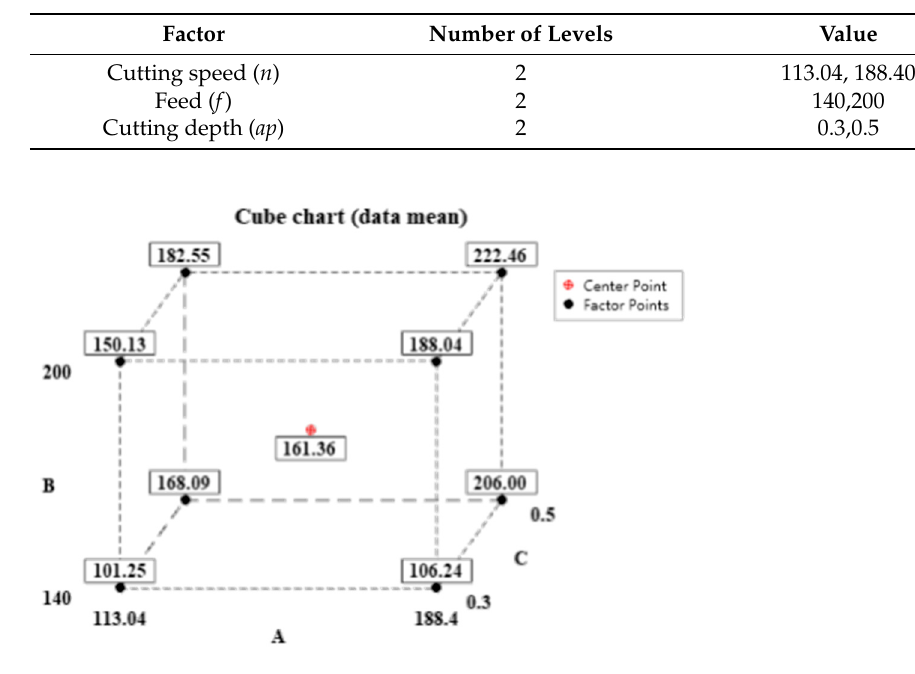
Figure 14. Cubic diagram .